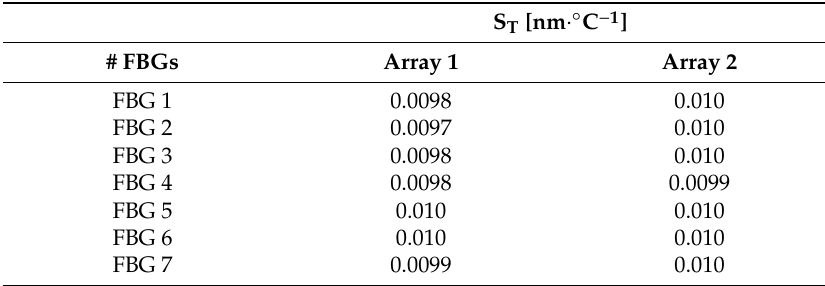
Table 1. The S T values of the FBGs embedded in Array 1 and Array 2 calculated as the slope of the best fitting